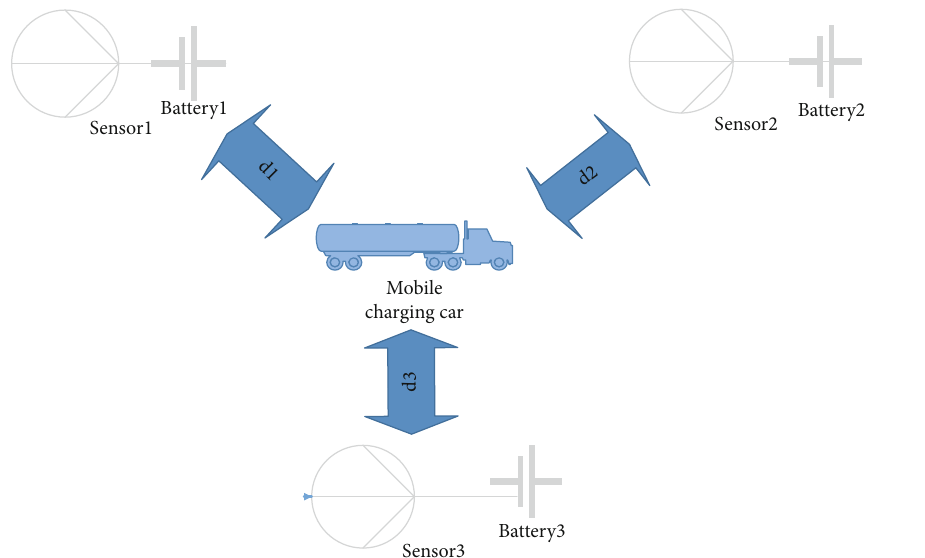
Figure 1: Structure of wireless sensor